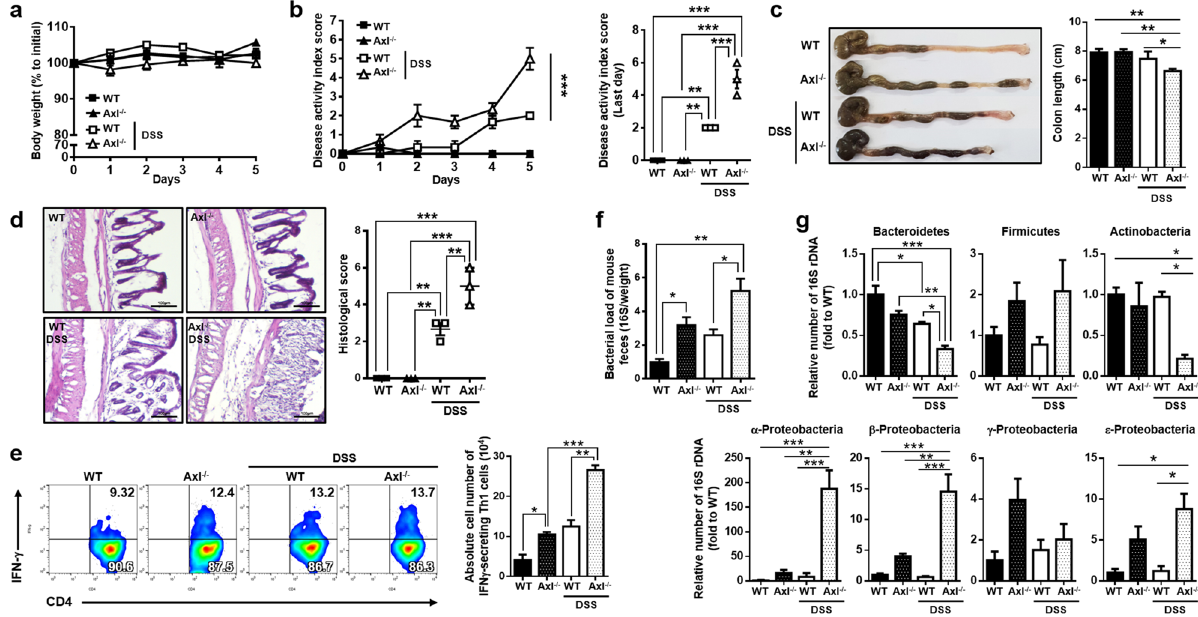
Figure 5. A deficiency of Axl exacerbated DSS-induced colitis by inducing an abnormal expansion of Proteobacteria. ( a ) Body weights and ( b ) DAI scores were measured every day during 2.5% of DSS administration for 5 days. ( c ) The macroscopic appearance of the colon (left panel) and the colon length (right panel) was measured on day 5 after DSS administration. ( d ) Representative microscopic images (magnification 200 ×) of colon tissues stained with H&E (left panel) and the histological scores (right panel) were evaluated as described in “Materials and methods”. ( e ) The populations of IFNγ-secreting activated Th1 cells were determined in the colon using flow cytometry analysis (left panel), and the absolute number of IFNγ-secreting activated Th1 cells was represented as a bar graph (right panel). ( f ) The bacterial load and ( g ) the relative number of bacteria were determined as described in “Materials and methods”. Significance (*p < 0.05, **p < 0.01, ***p < 0.001) was compared with each group and calculated by the one-way ANOVA. Data are representatives of three independent experiments (n = 3 mice per (Fig. 6a). The groups of FMT were eight: feces were transferred from WT mice to WT recipients (W to W), WT to Axl −/– mice (W to K), Axl −/– to WT (K to W), Axl −/– to Axl −/– (K to K) with or without DSS administration. There were no significant differences in body weight among the FMT groups (Fig. 6b). Interestingly, in the FMT groups administered with DSS, the symptoms of colitis, including the colon length, DAI, and histological scores, were aggravated when feces were transferred from Axl −/– mice to WT mice (K to W) compared with those of W to W (open symbols and bars) (Fig. 6b–e). The FMT of W to K led to more alleviated symptoms than that of K to K, whereas no significant differences were observed in the symptoms among the FMT groups not admin-